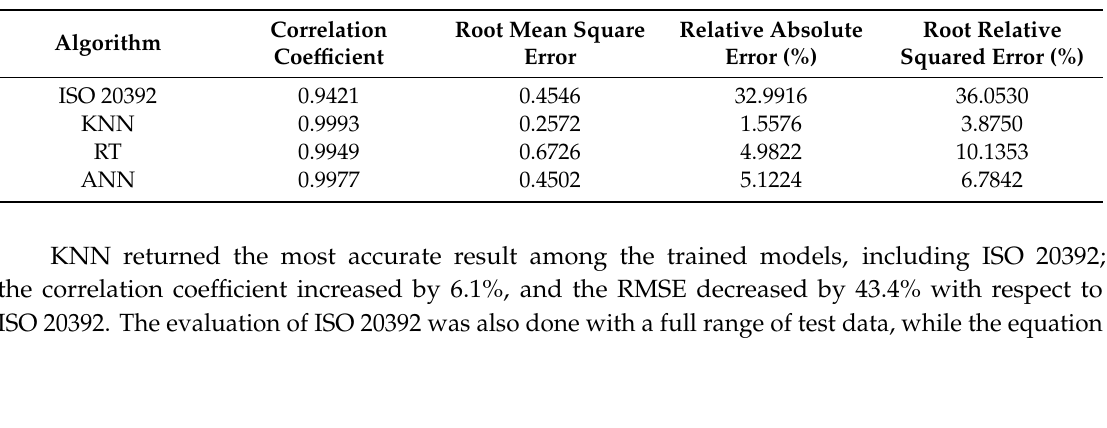
Table 3. Accuracy of predictions for each